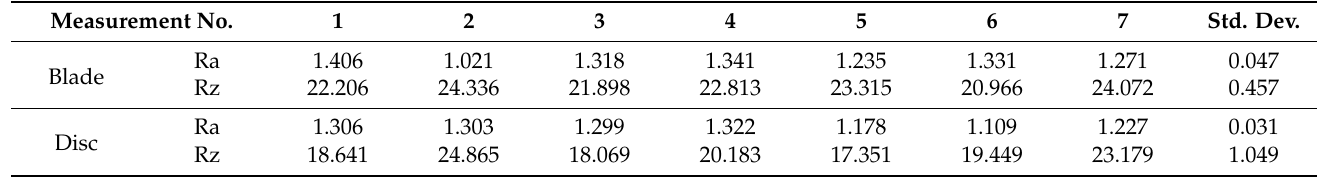
Figure 13. Composite impeller blades after manufacturing process. Table 5. Roughness evaluation for the composite